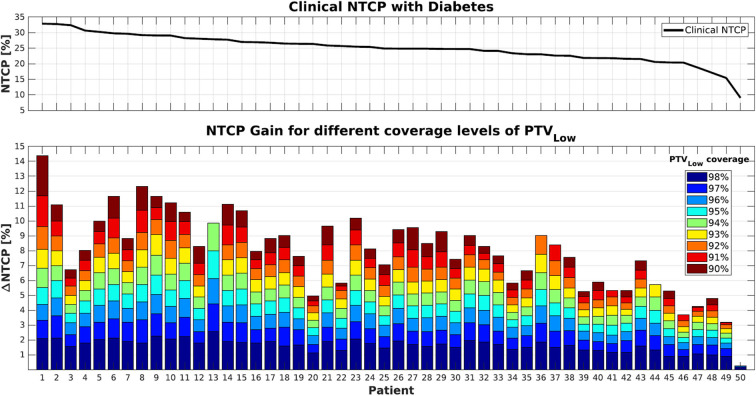
(Top) NTCP values for the clinical plans (PTVLow coverage ≥99%) in case of diabetes as a co-morbidity. (Bottom) Cumulative NTCP reductions for decreasing levels of PTVLow coverage. Patients were sorted according to their clinical NTCP as visualized in the top panel.